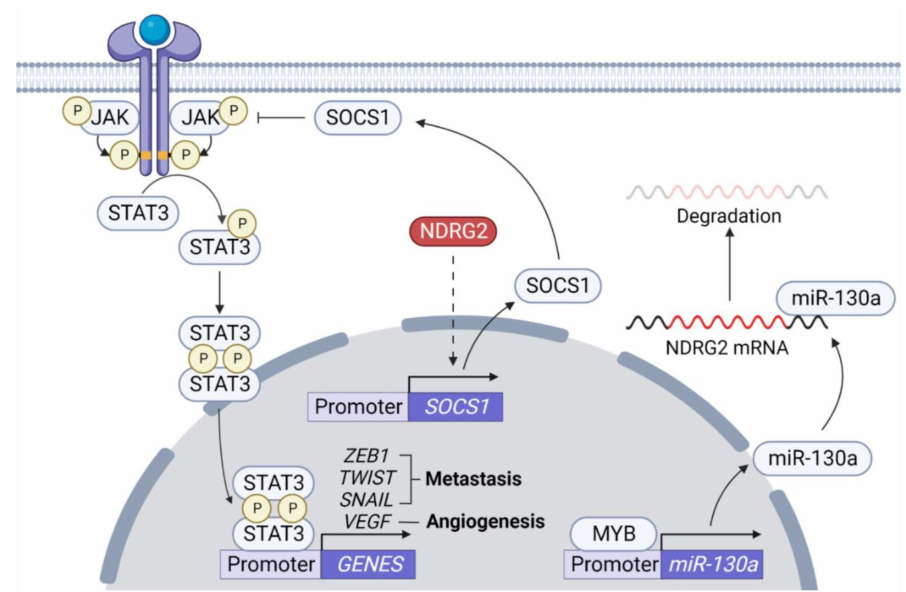
Figure 3. Inhibition of STAT3 activation pathway by NDRG2. JAK is activated upon cytokine or growth factors, resulting in dimerization through phosphorylation and nuclear translocation of STAT3 to induce transcription of metastasis-related genes, such as ZEB1 , TWIST , SNAIL , and VEGF . Cytokine signaling inhibitory factor (SOCS) protein is a representative negative regulator on JAK. NDRG2 induces SOCS1 expression through an unknown mechanism (dash line) and SOCS1 inhibits STAT3-mediated tumor cell metastasis by inhibiting JAK activation.